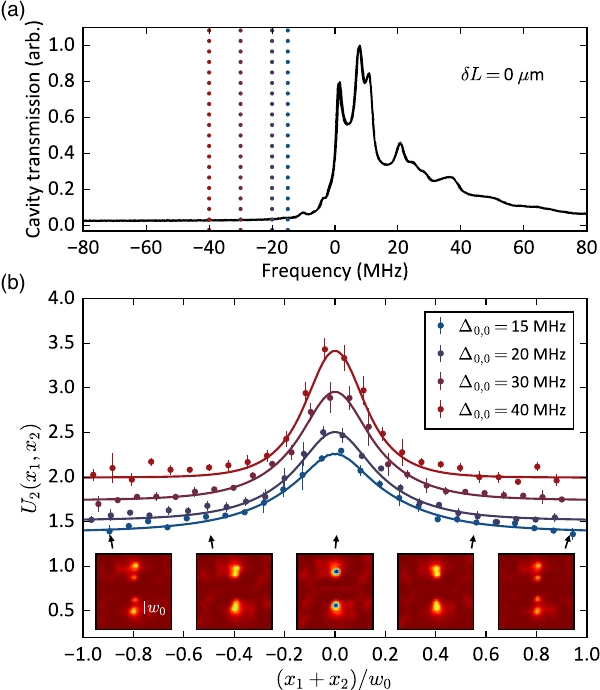
FIG. 5. Dimensionless interaction strengths for two intracavity BECs versus their center-of-mass position for various pump- cavity detunings Δ 0 . (a) Transmission spectrum of the δ L ¼ ; 0 0 μ m cavity. The dotted lines indicate the four values of Δ 0 ; 0 at which the interaction energy was measured. (b) The local interactions versus position between a real BEC at x 1 and the virtual BEC at − x 2 of a different real BEC at x 2 . The interaction strength saturates away from the center because of the self- interaction energy. The data were taken in the confocal configu- ration ( δ L ¼ 0 μ m) with the two BECs located on opposite sides of the cavity; see Fig. 1(b). Similar behavior is seen with δ L ≠ 0 cavities. Insets: The observed superradiant emission patterns for the data indicated. The white bar in panel (b) shows the length of the waist of the TEM 0 mode. Error bars represent standard ; 0